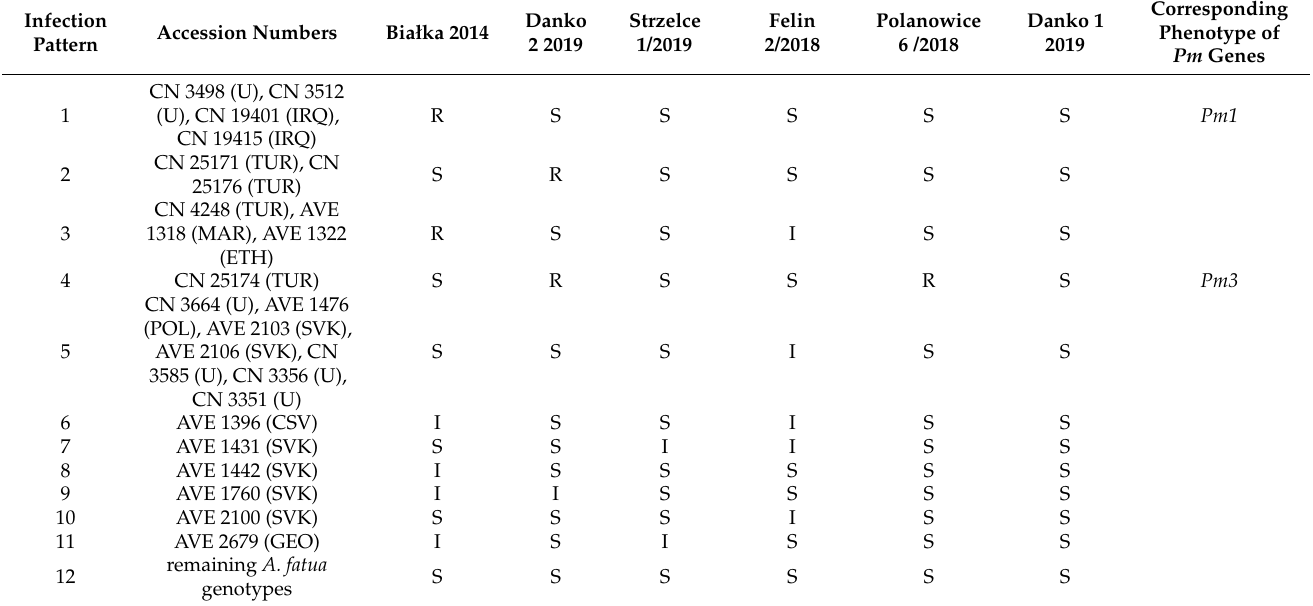
Table 3. Infection patterns and origin of analyzed A. fatua accessions based on the reaction to B. graminis f.sp. avenae isolates. Infection